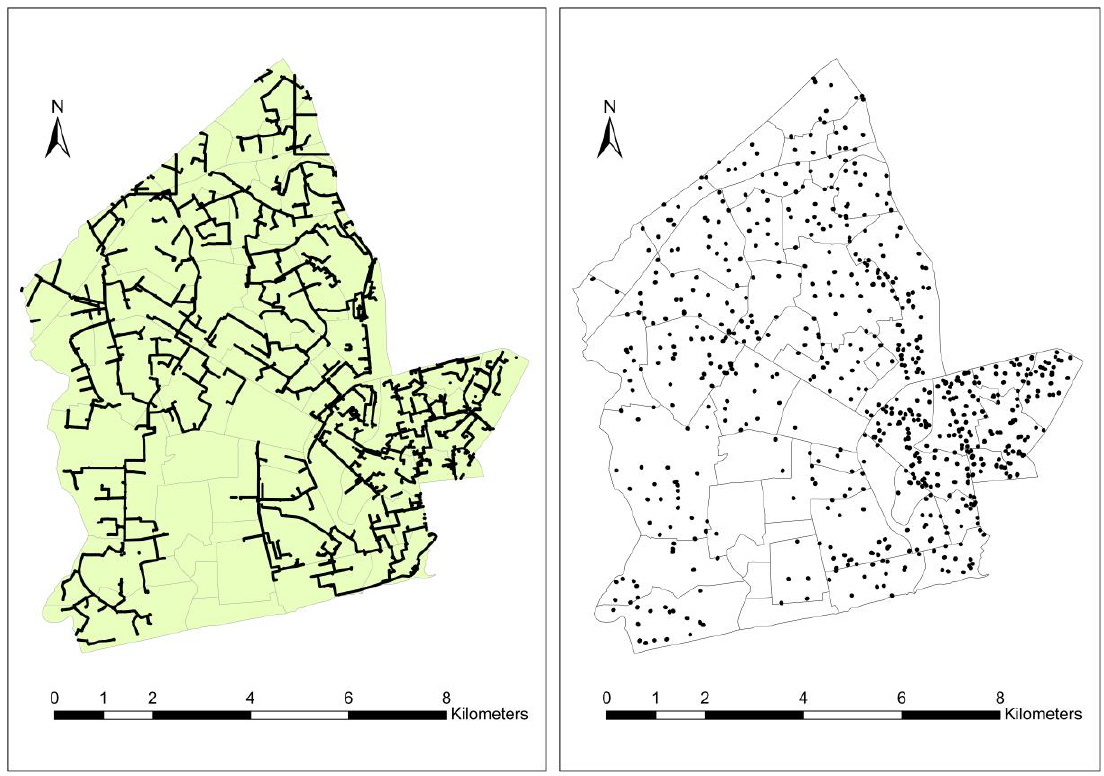
Figure 2. Map of neighborhoods overlaid with an 11 kV power distribution network ( left ) and overlaid with 11 kV distribution transformers ( right ).